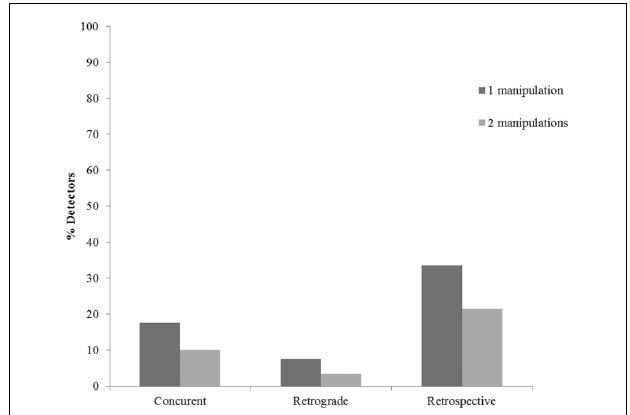
FIGURE 3 | Proportion of concurrent, retrograde, and retrospective detection rate as a function of warning conditions. Error bars represent bootstrapped 95% confidence intervals. Asterisk represents a statistically significant difference ( ∗ p <